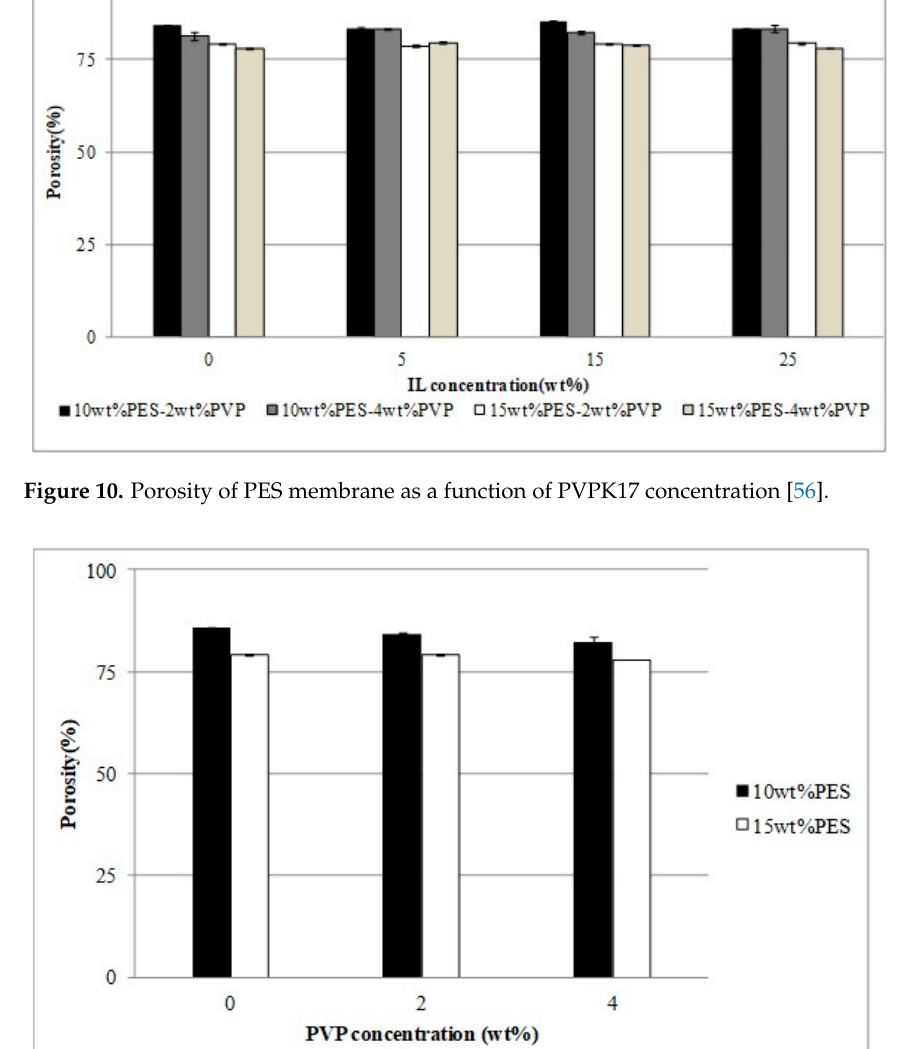
Figure 11. Porosity of PES membrane as a function of IL concentration [56].